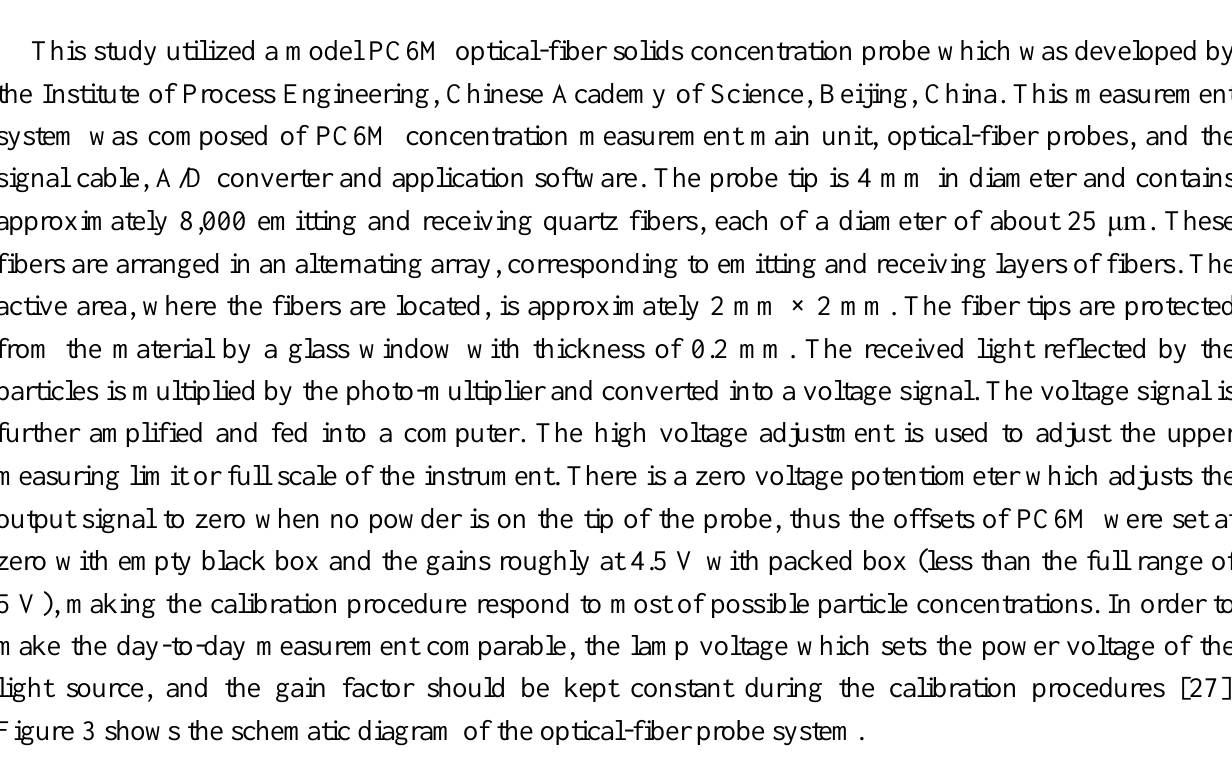
Figure 3. The optical-fiber probe system